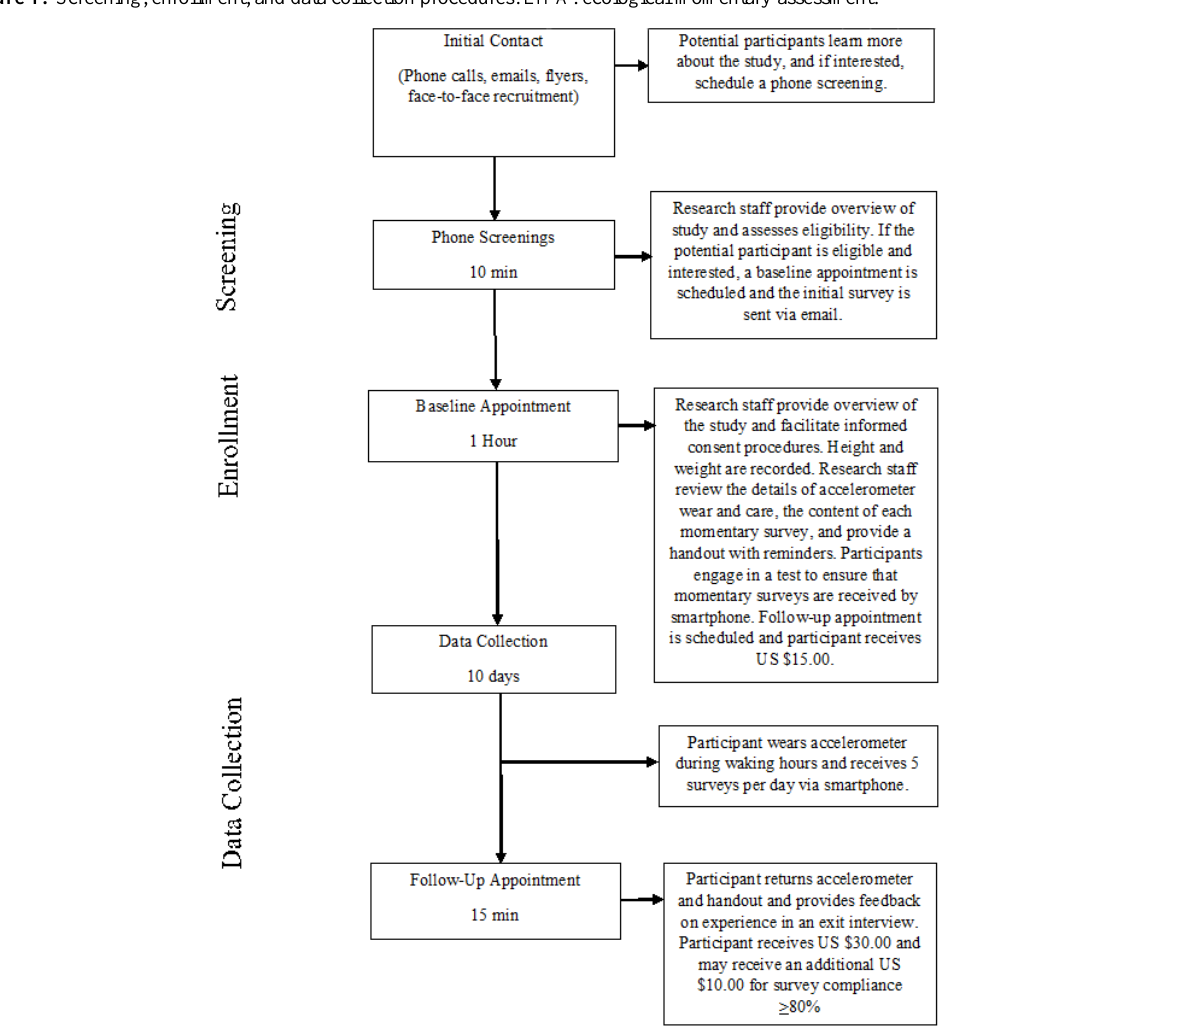
Figure 1. Screening, enrollment, and data collection procedures. EMA: ecological momentary